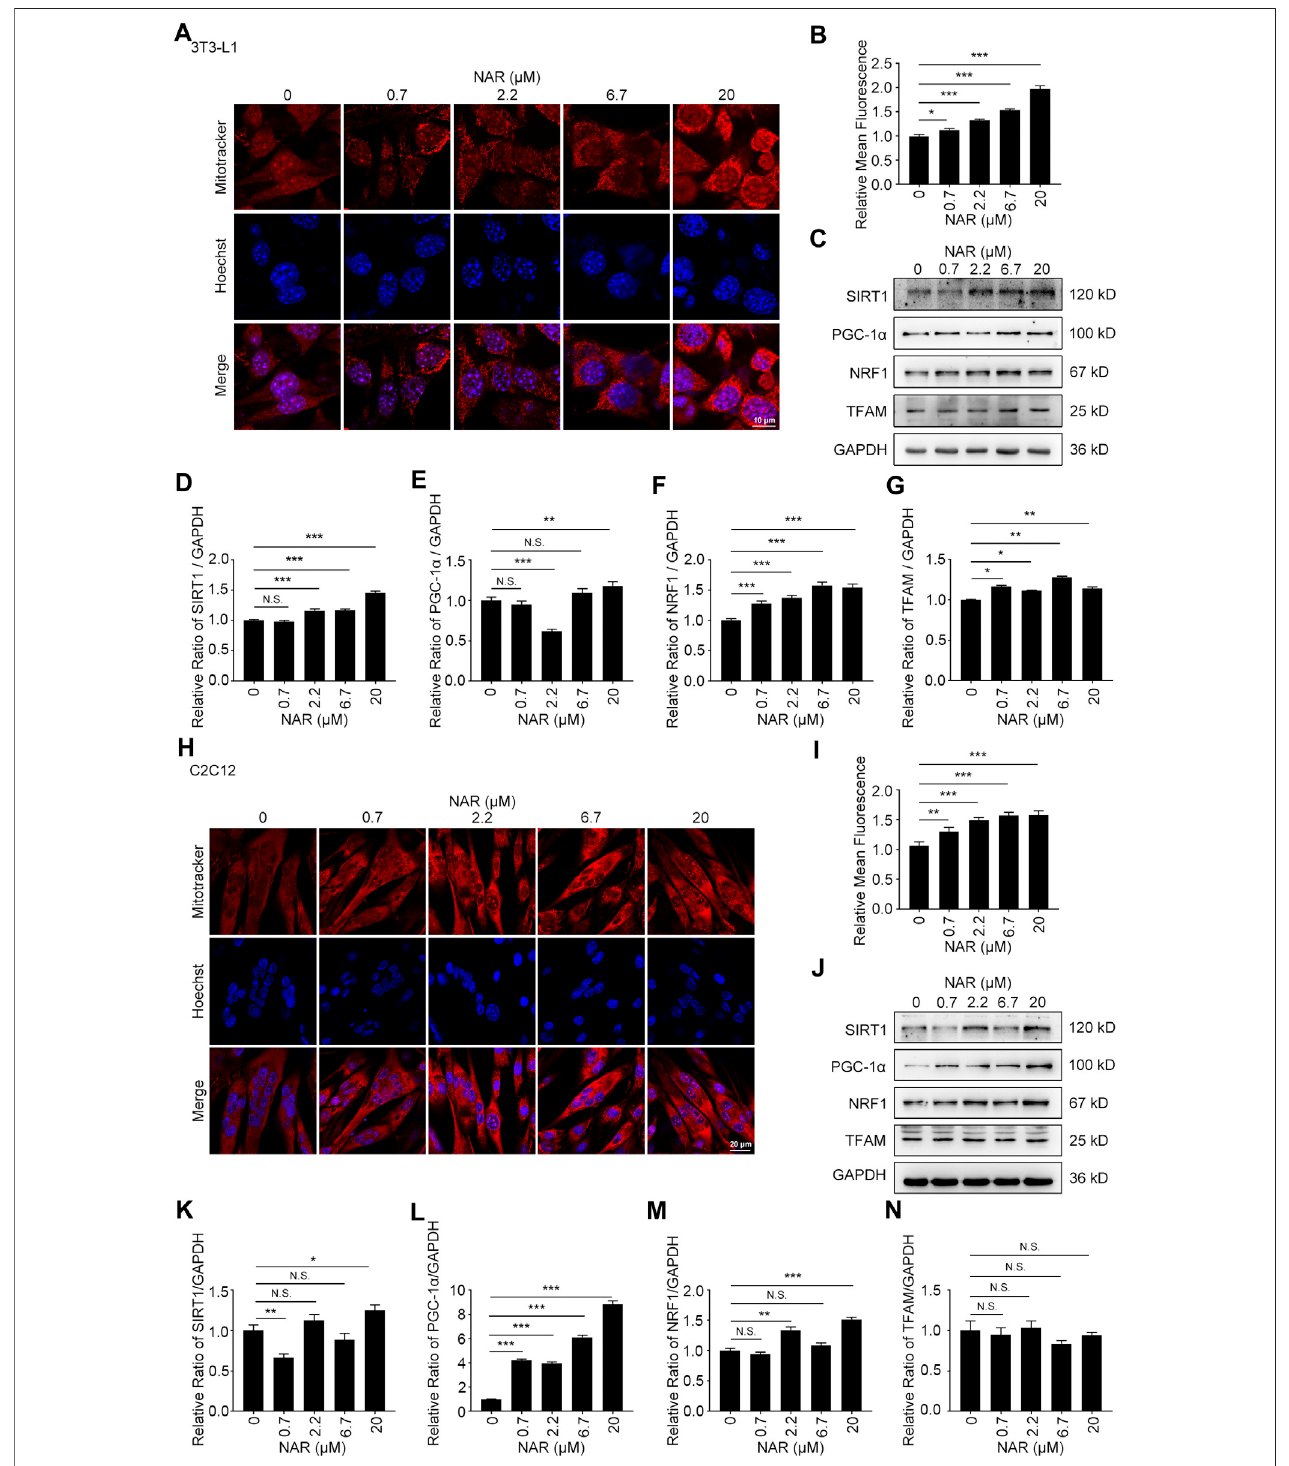
FIGURE 4 | NAR promotes mitochondrial biogenesis of 3T3-L1 adipocytes and C2C12 myotubes. The mass of mitochondria in 3T3-L1 adipocytes ( (A,B) , the objective ampli fi cation 63 × ) and C2C12 myotubes ( (H,I) , the objective ampli fi cation 20 × ) after treatment of NAR was detected by mitotracker orange staining (red). The expression of SIRT1, PGC-1 α , NRF1, and TFAM in 3T3-L1 adipocytes (C – G) and C2C12 myotubes (J – N) was determined by Western blotting. Bars represent 10 μ M (A) , 20 μ M (H) . All values were expressed as the mean ± SD from three or more independent experiments. *** p < 0.001; ** p < 0.01; * p < 0.05 vs. untreated cells.; Abbreviation: NAR, naringenin; SIRT1, sirtuin1; PGC-1 α , peroxisome proliferator-activated receptor coactivator 1 α ; NRF1, nuclear respiratory factor 1; TFAM, mitochondrial transcription factor A.